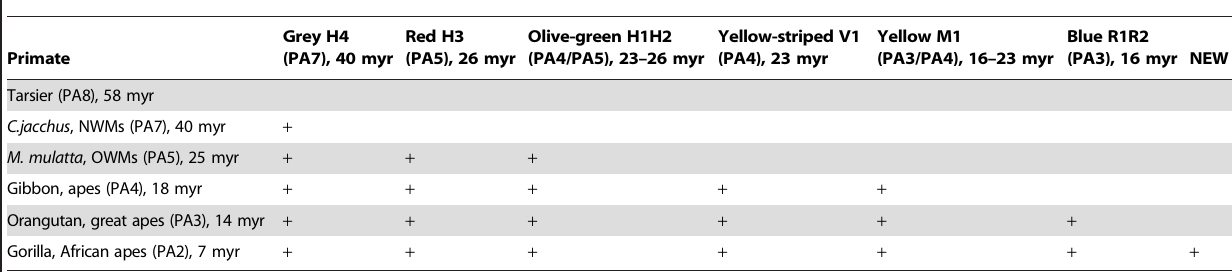
Table 2. Search for human AS layers in various primates.